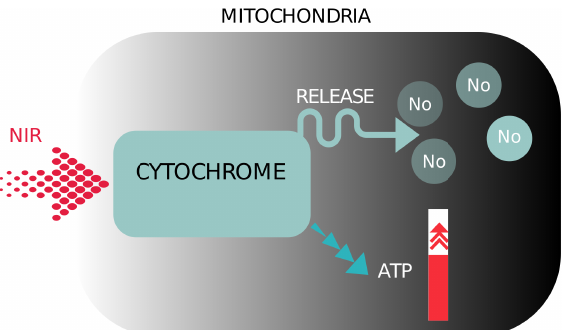
Figure 1. Illustration of the schematic representation of the mechanisms of photobiomodulation near infrared